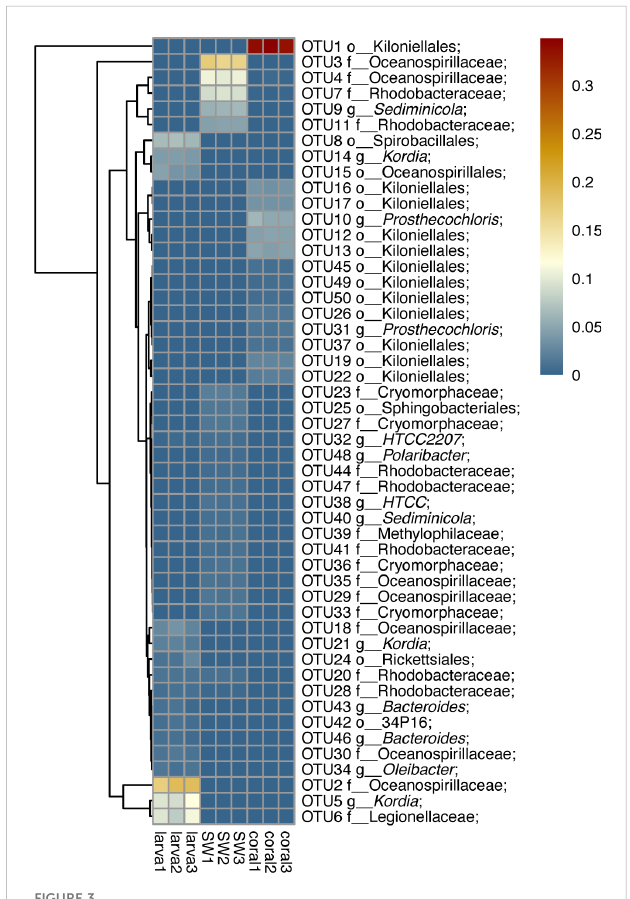
FIGURE 3 Heat map re fl ecting the relative abundance and distributions of the top 20 OTUs. The scales 0.01 and 0.1 show the abundance at 5% and 10%,